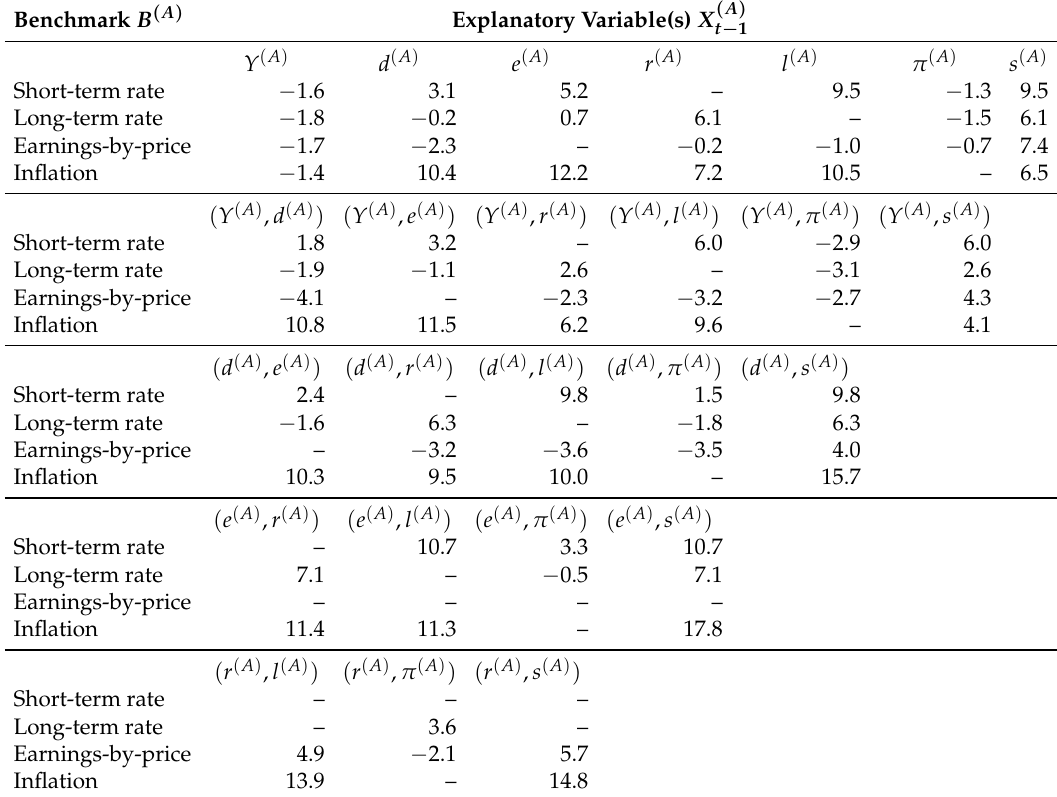
Table 4. Predictive power measured by R 2 benchmarking